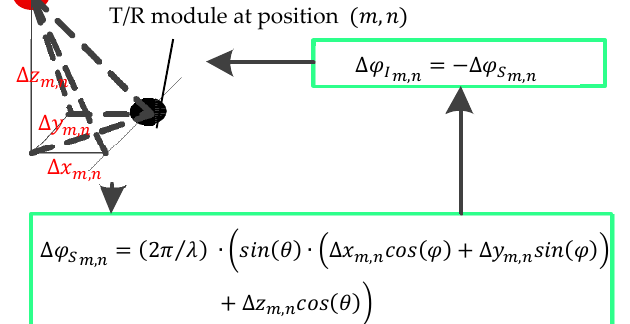
Figure 6. Schematic diagram of a rectangular array of the phased array antenna (PAA).